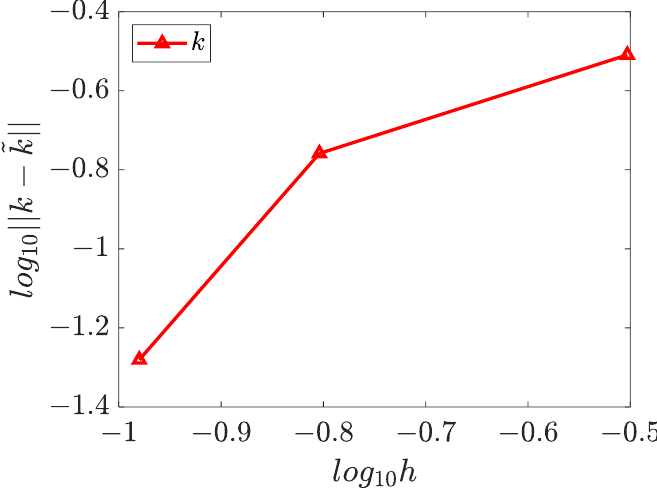
Figure 18. Convergence of the solutions for the 2D varying parameter identification problem.